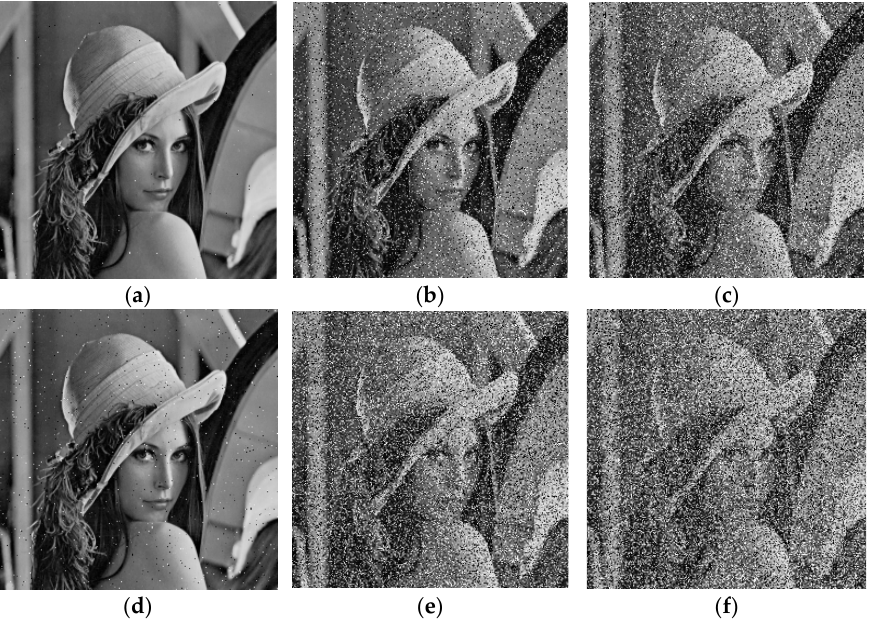
Figure 12. The results of a noise attack ( a ) SPN with density = 0.001; ( b ) SN with variance = 0.00001; ( c ) GN with mean = 0 and variance = 0.00001; ( d ) SPN with density = 0.01; ( e ) SN with variance = 0.0001; ( f ) GN with mean = 0 and variance = 0.0001.